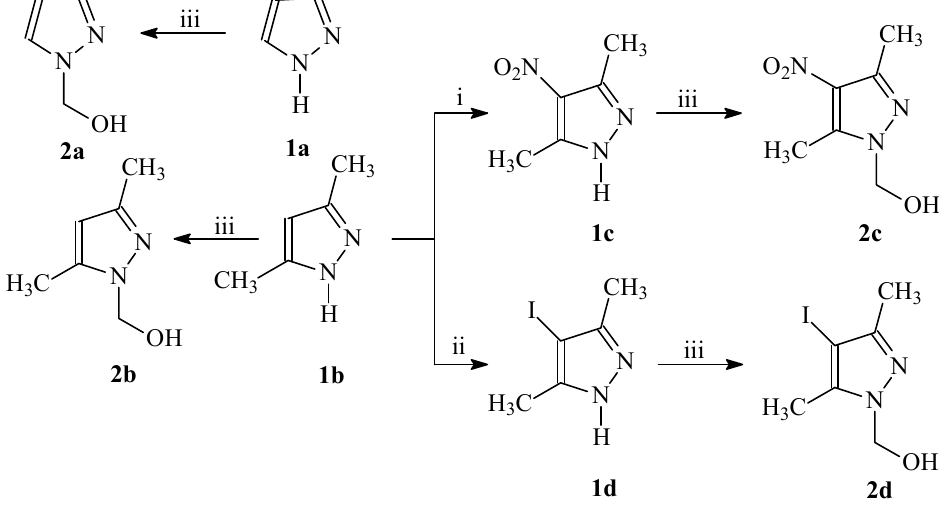
Scheme 1. Synthesis of substituted pyrazoles. Reagents: acetylacetone, hydrazine hydrate ( 1b ); (i) HNO 3 /H 2 SO 4 ( 1c );(ii) I 2 /KI, AcONa ( 1d ); (iii) CH 2 O, MeOH ( 2a–d ).